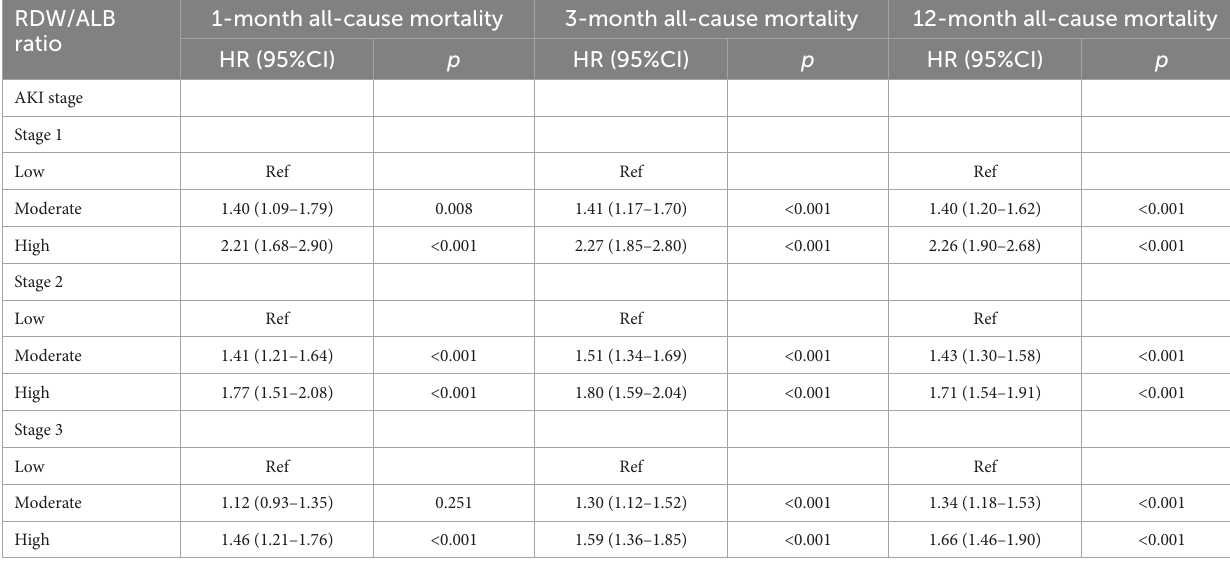
TABLE 6 Hazard ratios (HRs) for the all-cause mortality of AKI patients based on AKI stage. RDW/ALB 1-month all-cause mortality 3-month all-cause mortality 12-month all-cause ratio